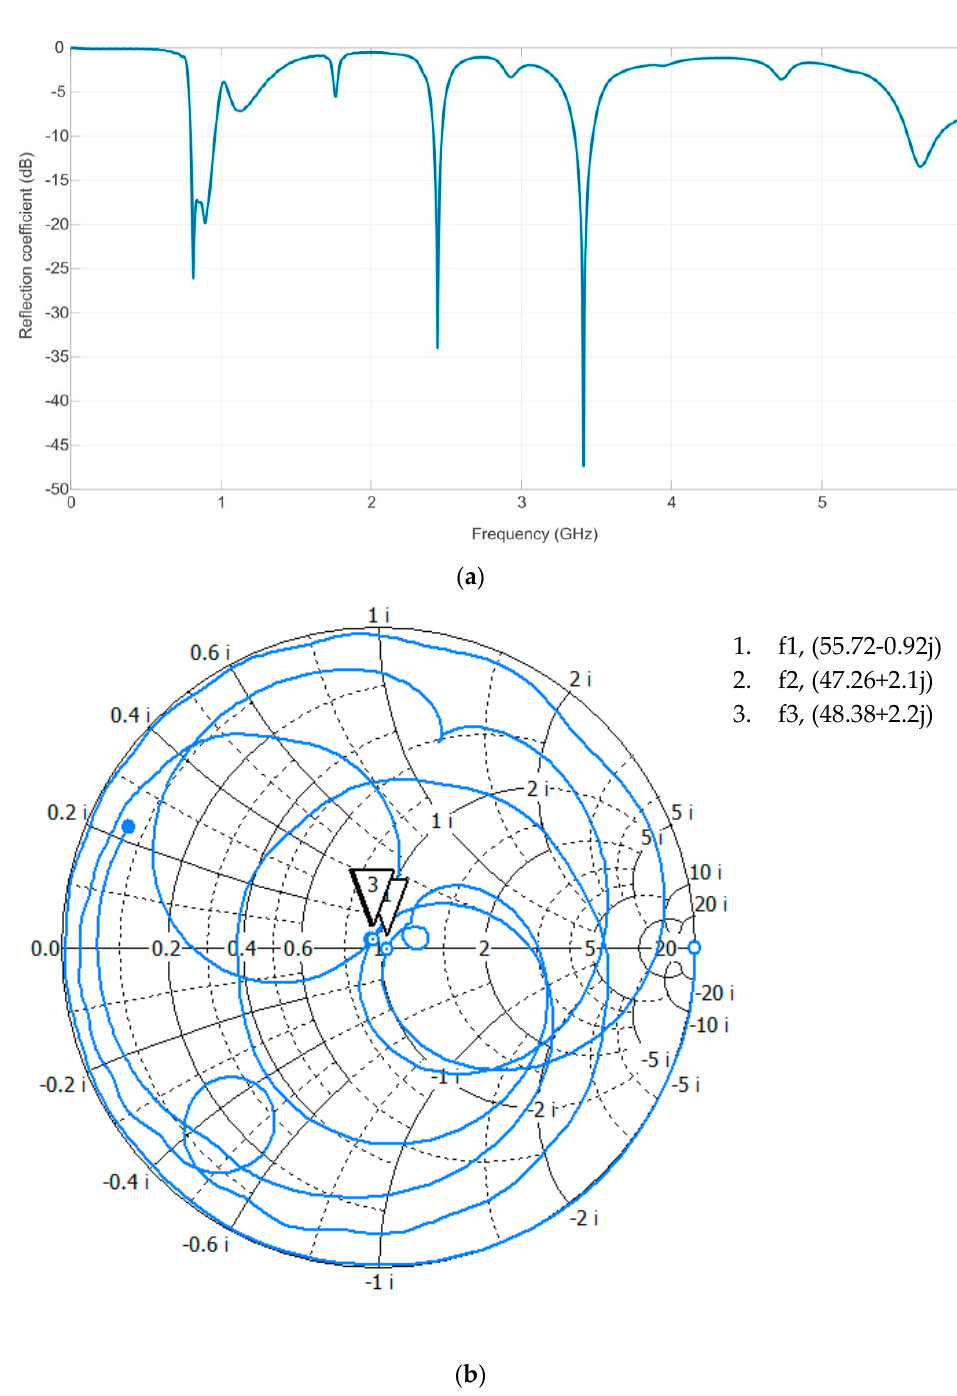
Figure 7. Reflection coefficient of the proposed antenna optimized for f 1 , f 2 and f 3 frequency bands. ( a ) Reflection coefficient in dB; ( b ) reflection coefficient in Smith Chart.